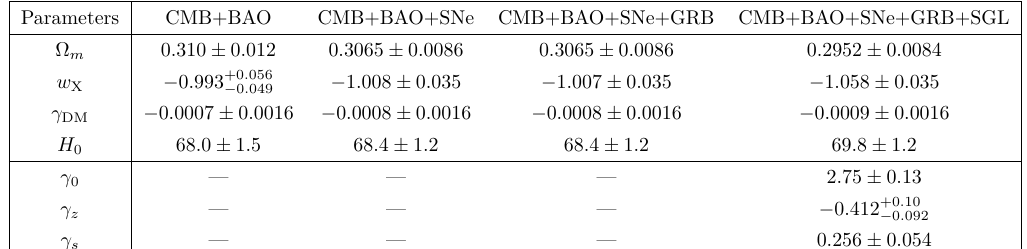
2 . The best values and their 1 σ errors of the γ DM model parameters